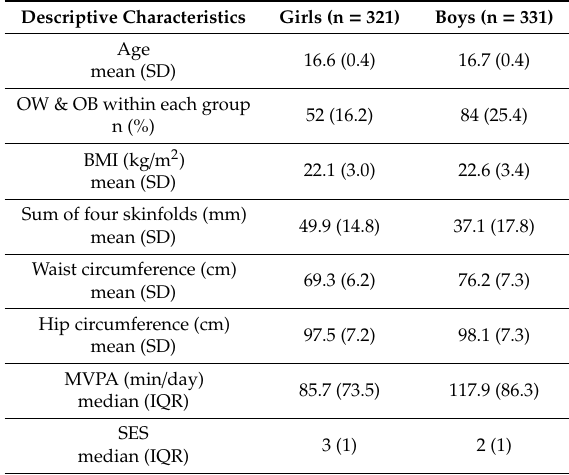
Table 1. Characteristics of the study sample stratified by